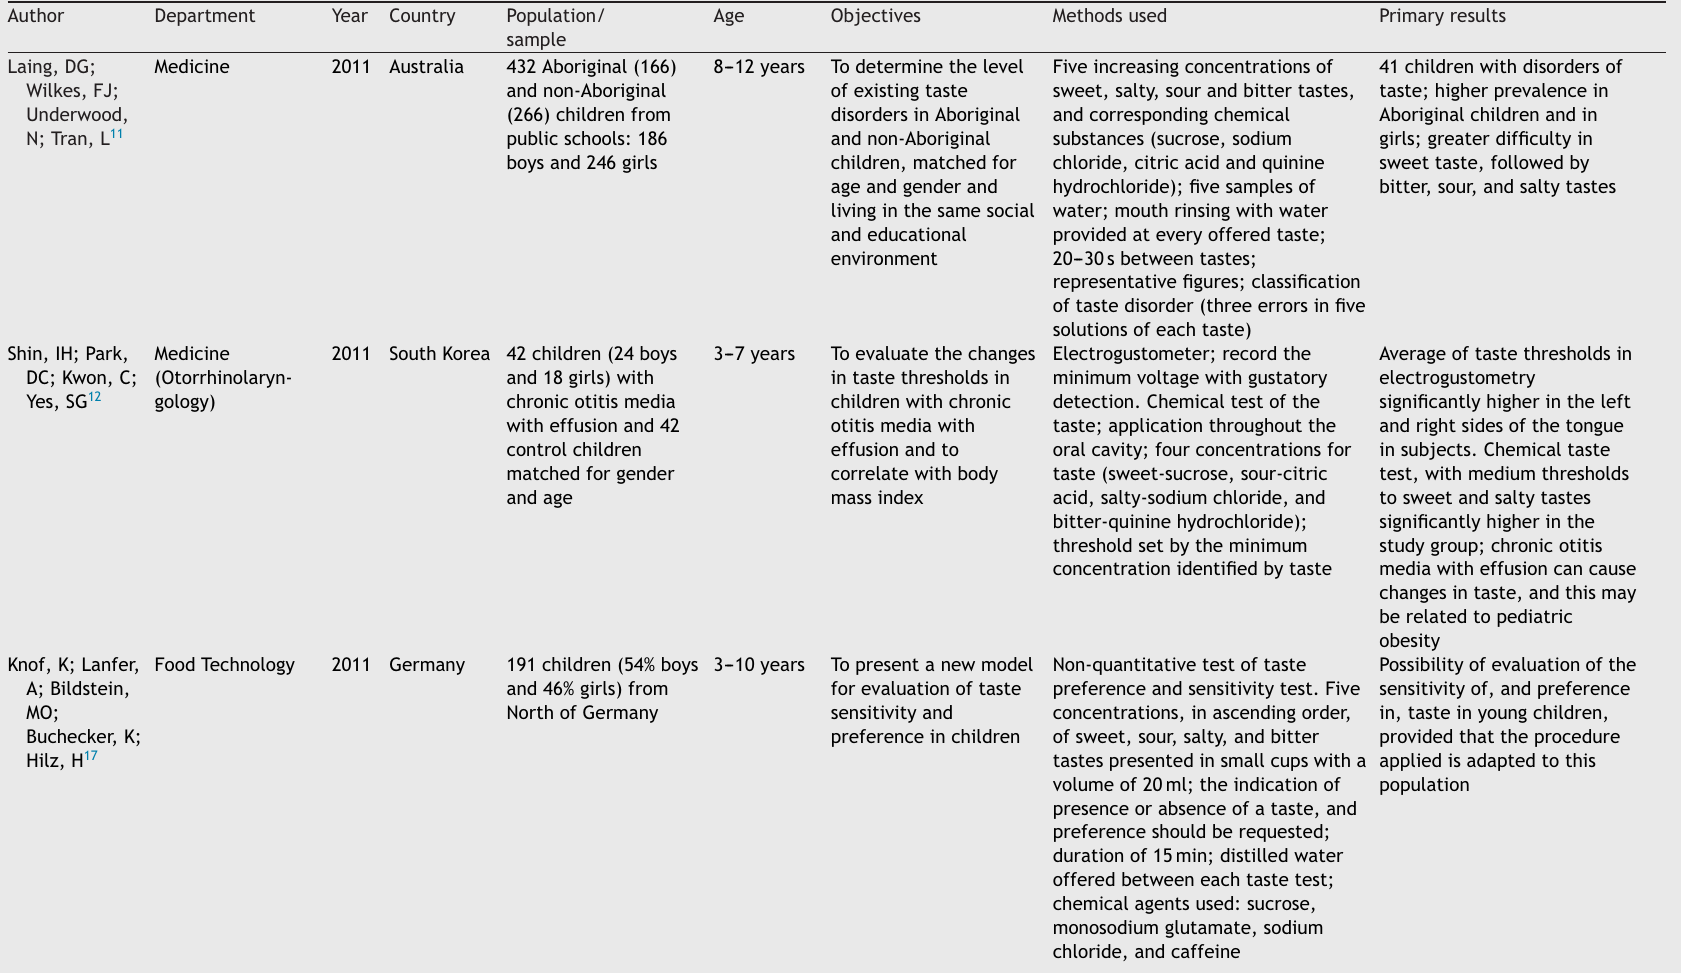
Results of selected studies according to the variables